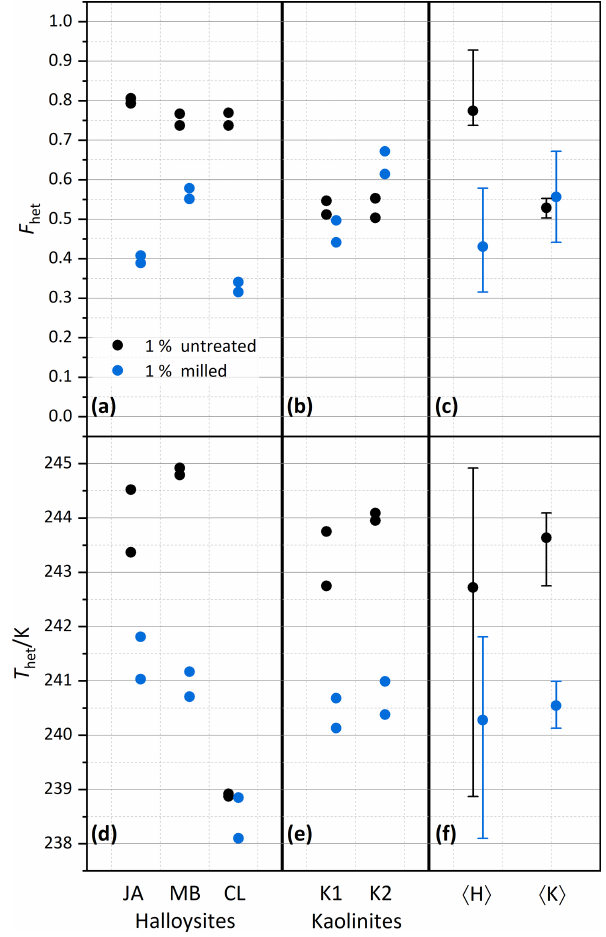
Figure 5. Summary of the effect of milling on heterogeneously frozen factions F het (a–c) and heterogeneous freezing onset tem- peratures T het (d–f) of 1wt% halloysite and kaolinite samples (with sample codes identical to those in Fig. 2). Experiments have been performed for samples immersed without prior milling (black sym- bols) and immersed after prior milling (blue symbols). Each sam- ple and milling procedure was measured twice. (a, d) Halloysites. (b, e) Kaolinites. (c, f) Averages for the halloysites, (cid:104) H (cid:105) , and for the kaolinites, (cid:104) K (cid:105) , with vertical bars representing the spread (min– max) of all